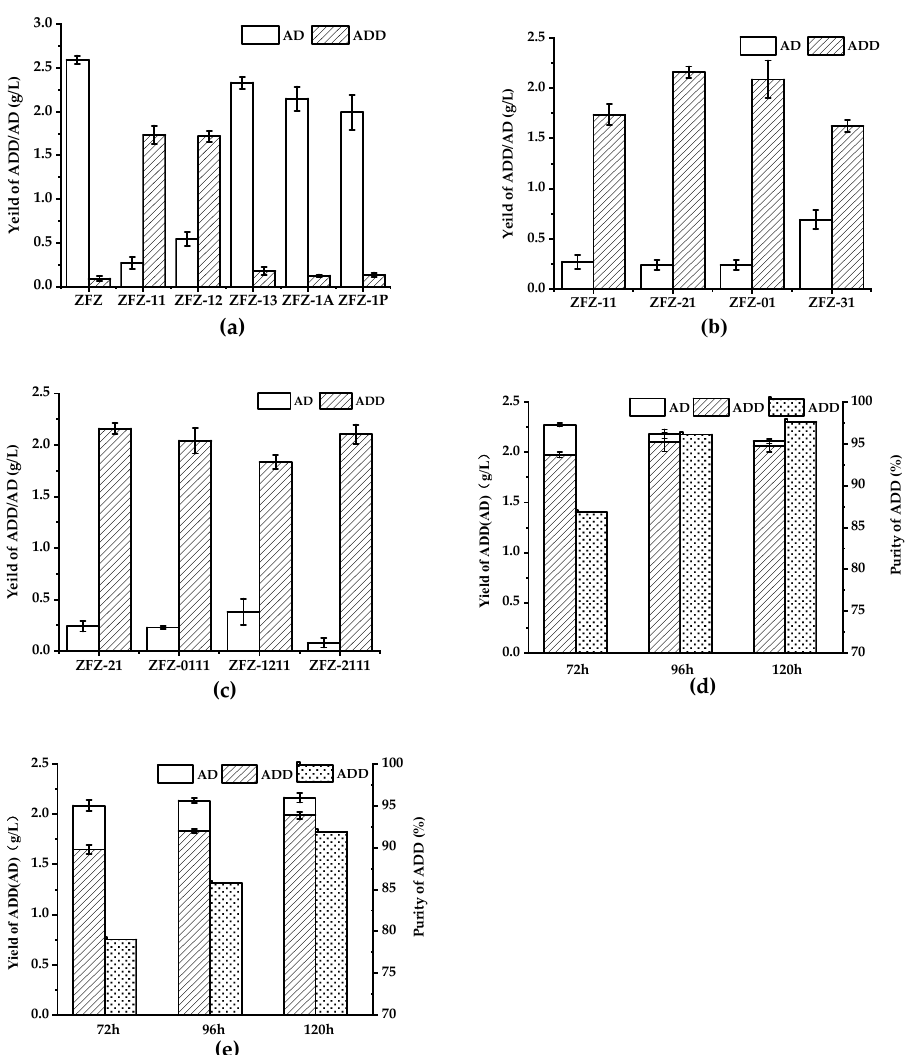
Figure 5. The phytosterols bioconversion in the oil-aqueous two-phase system by engineered strains. The biotransformation was carried out for four days with 5 g L − 1 of phytosterols as the substrate. ( a ) The effects of different KSDDs on the ADD yield. ( b ) The effects of different promoters on the ADD yield. ( c ) The effects of a tandem ksdd expression box on ADD yield. ( d ) The phytosterol biotransformation by ZFZ-2111 was carried out with soybean oil. ( e ) The phytosterol biotransformation by ZFZ-2111 was carried out with waste cooking oil. All assays were performed in triplicate, with three independent measurements.